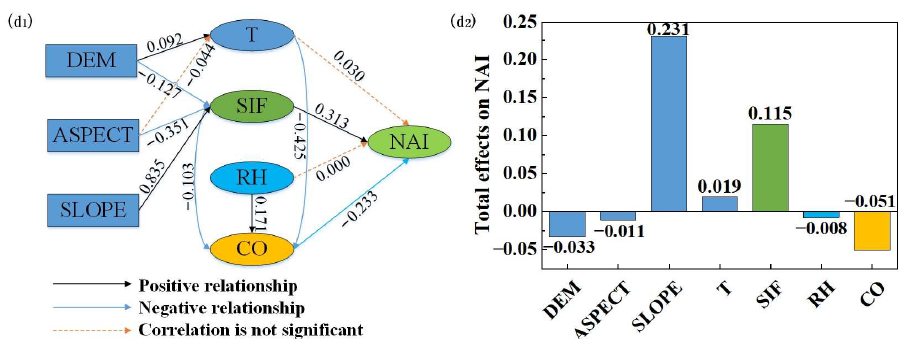
Figure 7. Path analysis diagram illustrating relationships among terrain (DEM, aspect, slope), environmental factors (T, CO, RH), plant photosynthesis (SIF), and NAIs and the total effects of the drivers on NAIs for all land types ( a 1 , a 2 ), forest land ( b 1 , b 2 ), urban and built-up lands ( c 1 , c 2 ), and cropland ( d 1 , d 2 ).